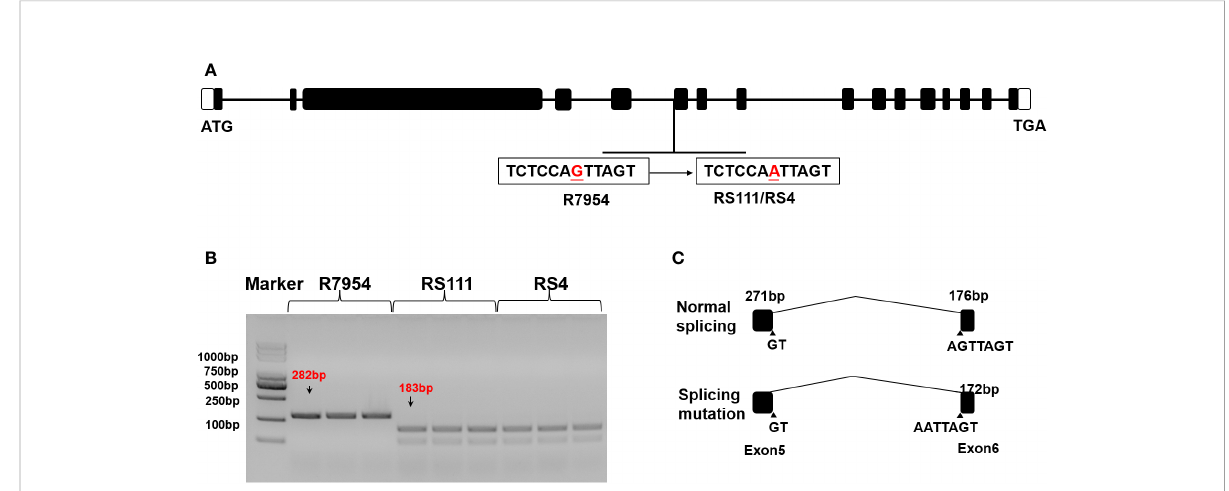
FIGURE 1 SSIIIa sequence variations in wild type (WT) (R7954) and mutants (RS111 and RS4). (A) Genomic sequencing of WT and mutants. (B) Genotyping of SSIIIa alleles using the SSIIIa CAPS marker. (C) Varied splicing of transcripts in WT and